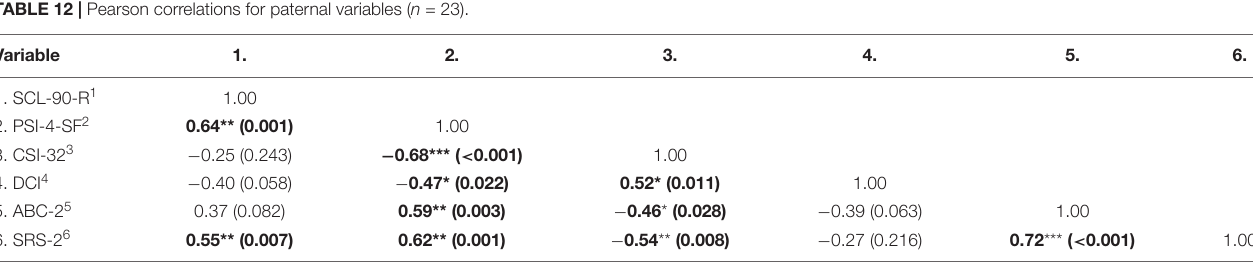
TABLE 12 | Pearson correlations for paternal variables ( n = 23).